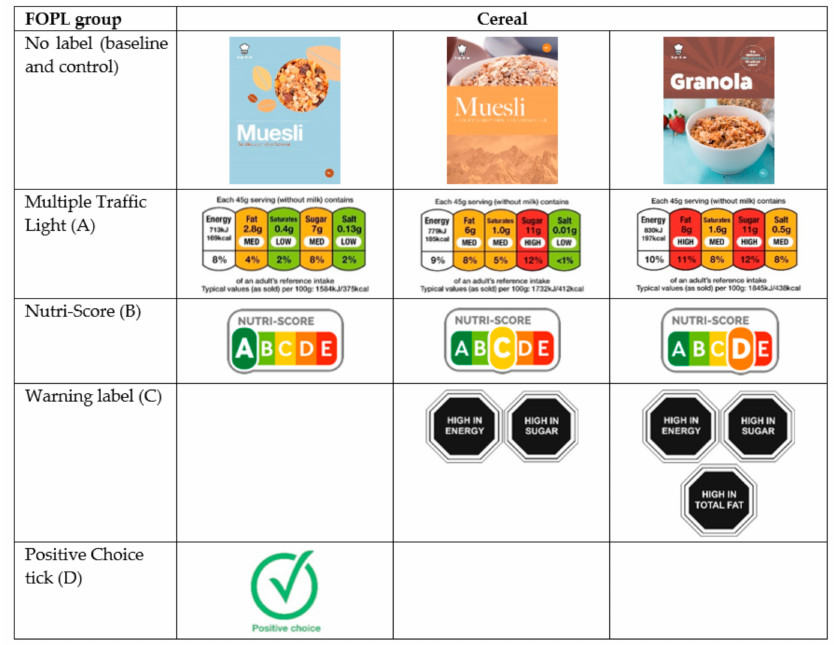
Figure 1. Example of the breakfast cereal products used for ranking tasks, with the associated front of pack